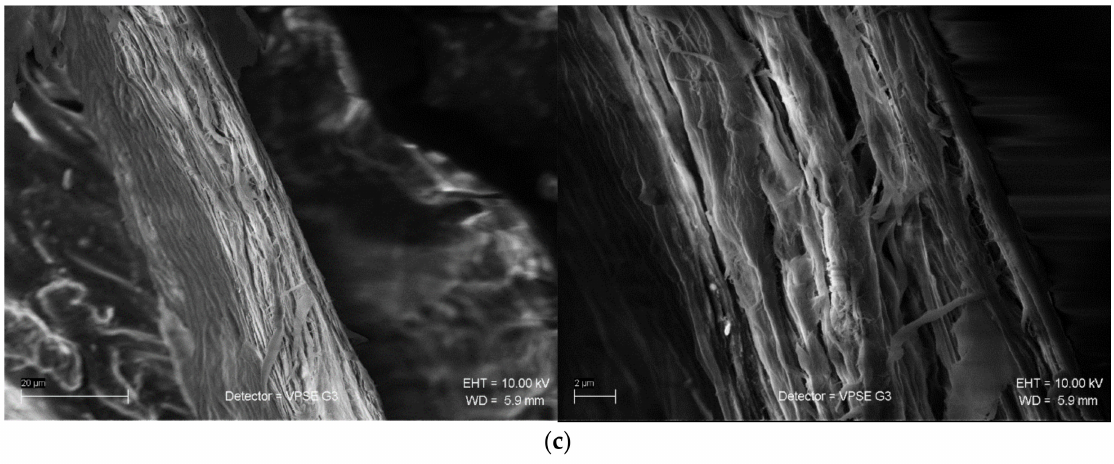
Figure 5. The SEM pictures of nanocellulose fibres from ( a ) garlic, ( b ) onion, ( c ) pineapple; @